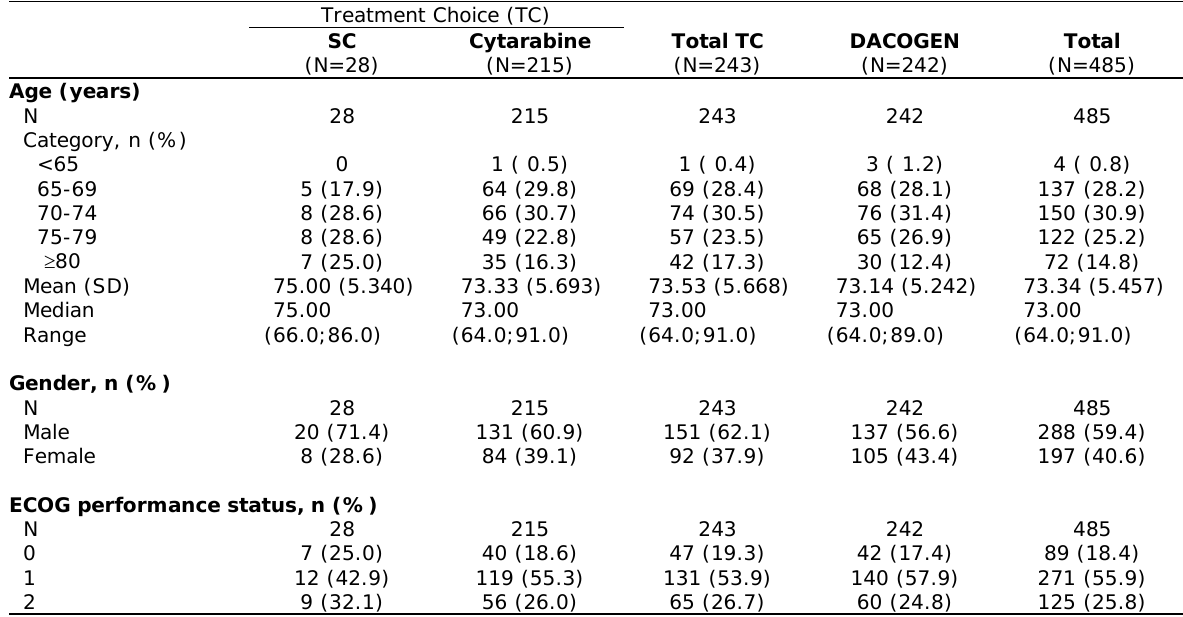
Table 16: Demographic and Baseline Characteristics (Study DACO-016) (Intent-to-Treat Analysis